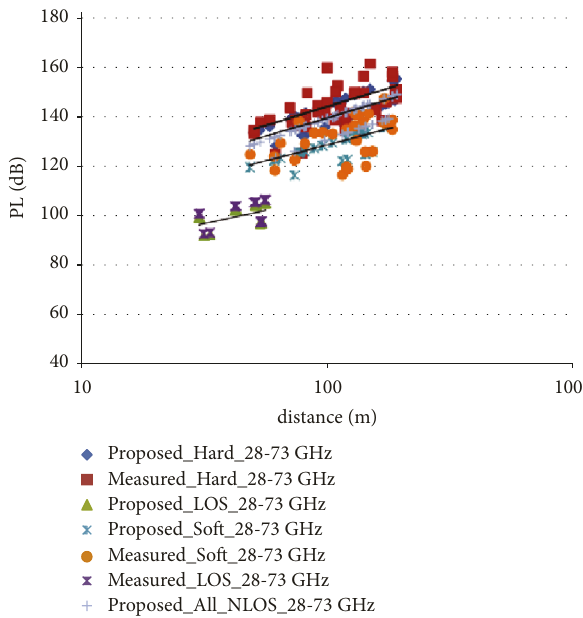
Figure 7: Proposed Model at frequency of 28 and 73GHz.